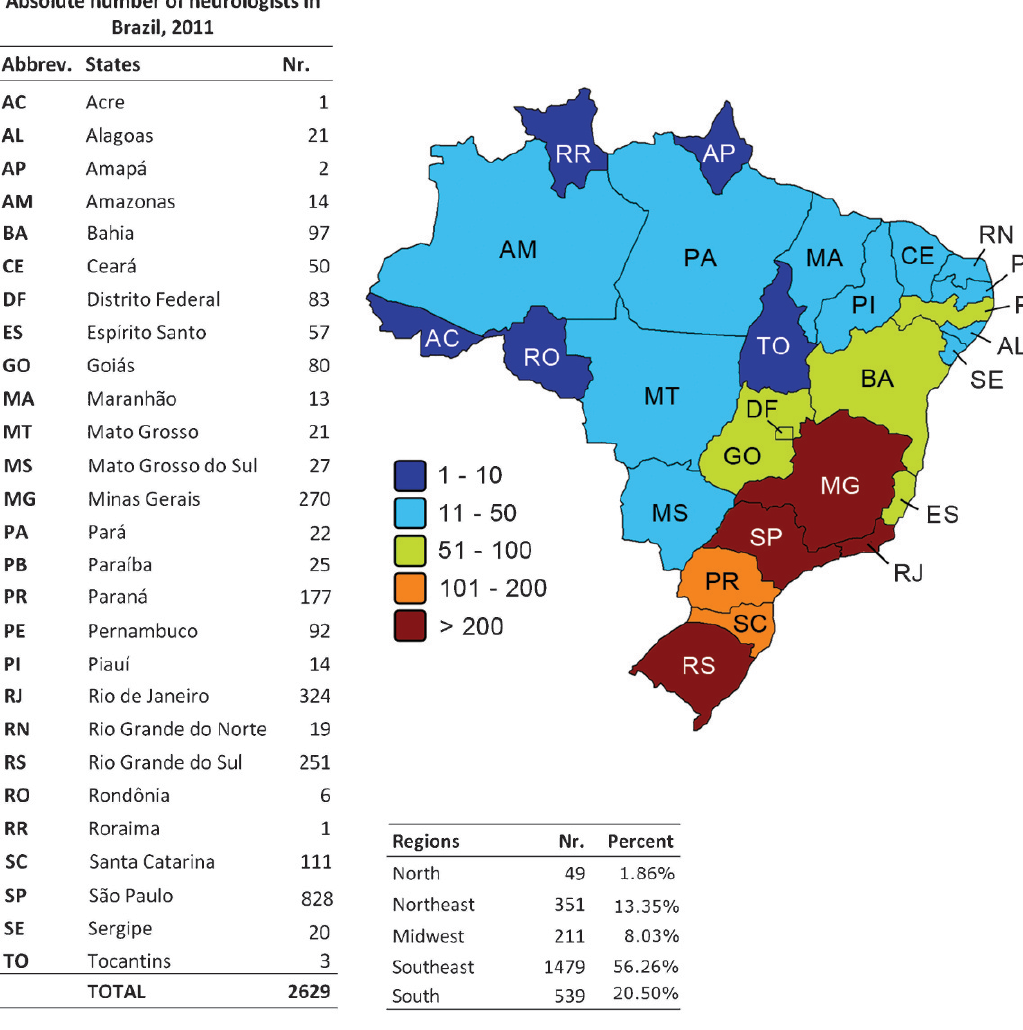
Figure 1 - Absolute numbers of neurologists in Brazil; obtained from the Report of Medical Demography in Brazil - General Data and Descriptions of Inequalities, Volume 1 (Brazilian Federal Council of Medicine; Regional Council of Medicine of Sa˜o Paulo, December